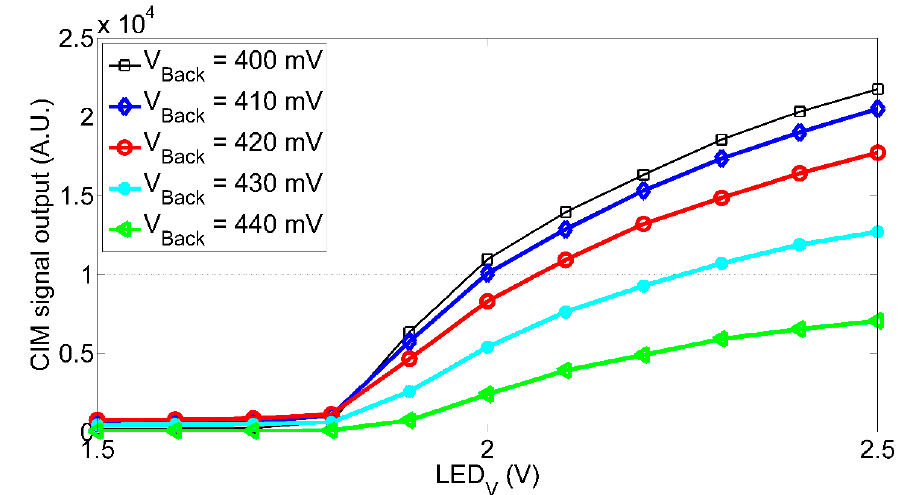
Figure A4. CIM signal output as function of the LED signal pulse amplitude for different background levels.